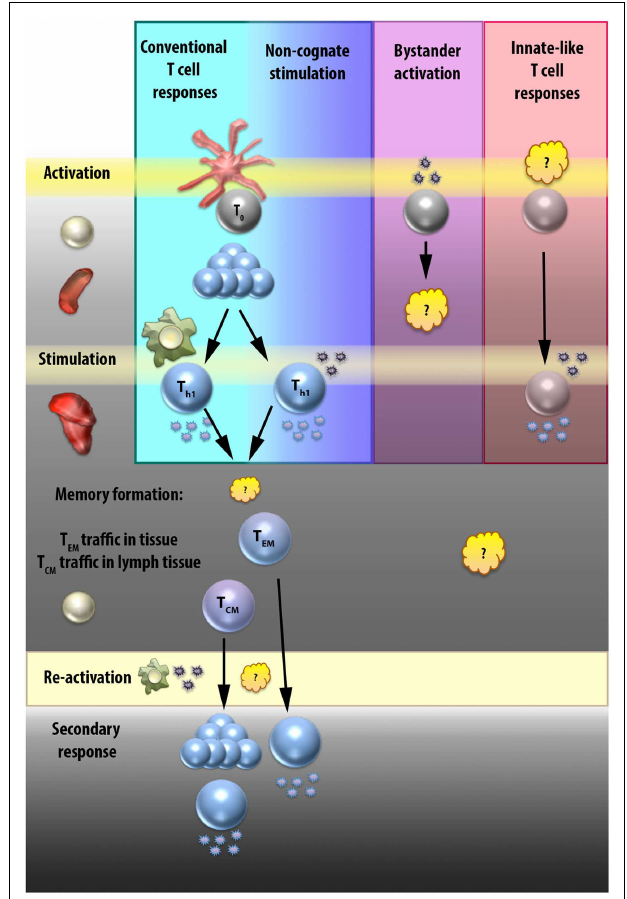
FIGURE 3 | Elicitation of CD4 and “innate-like”T cell effector functions . T cell effector functions can result from interactions with APCs or cytokines at various stages. In the conventionalT cell response (first column, blue), naïveT cells are activated by direct interactions with APCs in the secondary lymphoid tissues, proliferate, migrate to sites of infection, and then are stimulated by secondary direct APC contact to produce effector cytokines. Some of these effectorT cells will go on to become memoryT cells.T central memory (T CM ) cells circulate in secondary lymphoid tissues, and upon re-activation will once again proliferate and differentiate into effector cells.T effector memory (T EM ) cells can either migrate in the periphery or be resident in tissue, and respond more rapidly than theT CM cells because upon re-activation they can secrete effector cytokines directly.The signals that result in theT EM orT CM fate decision are still unclear, as are the interactions required by each for re-activation, although it is presumed